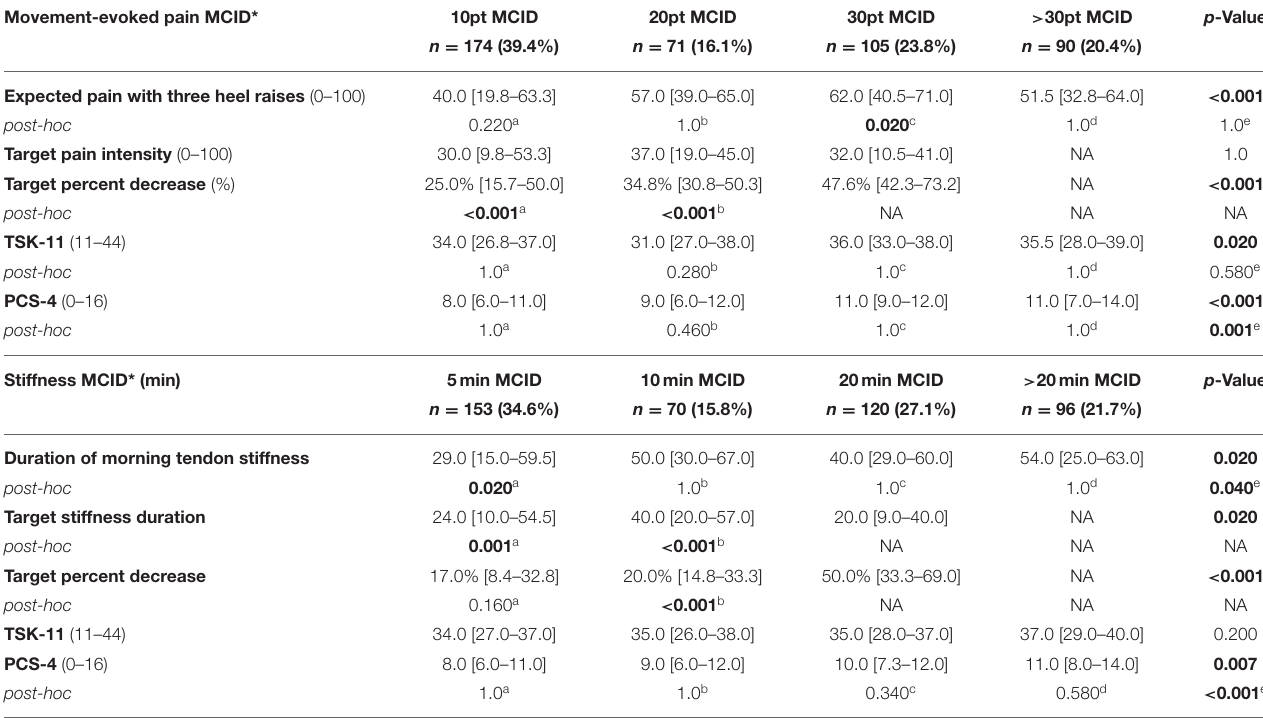
TABLE 4 | Based on response to minimal clinically important difference (MCID) questions for pain during single leg heel raises and duration of morning tendon stiffness, four subgroups were defined each symptom. Movement-evoked pain